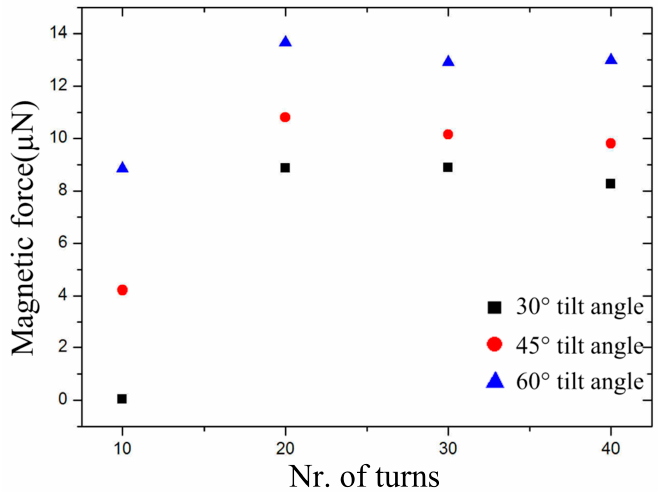
Figure 4. Simulated magnetic force with increasing turns (from 10 to 40) with tilt-angle of 30°, 45° and 60°, respectively.